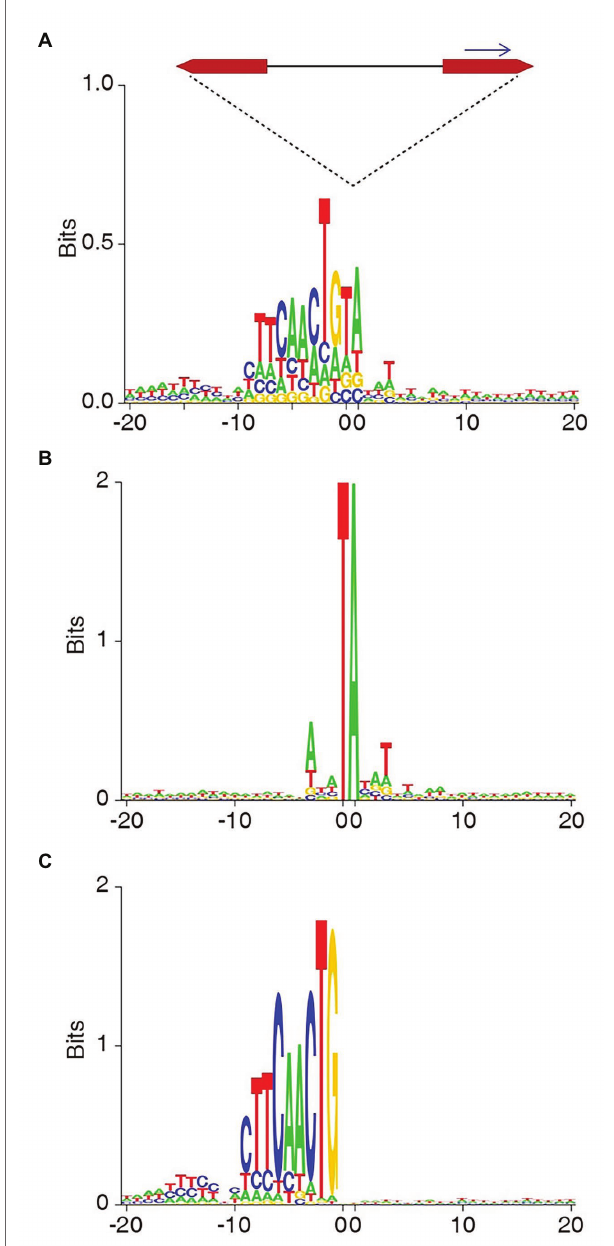
FIGURE 4 | The target site consensus sequences of the total (A) , TA (B) , and non-TA (C) integrations identified from the raw next generation sequencing (NGS) data of the SB mutagenesis study by Chen et al.